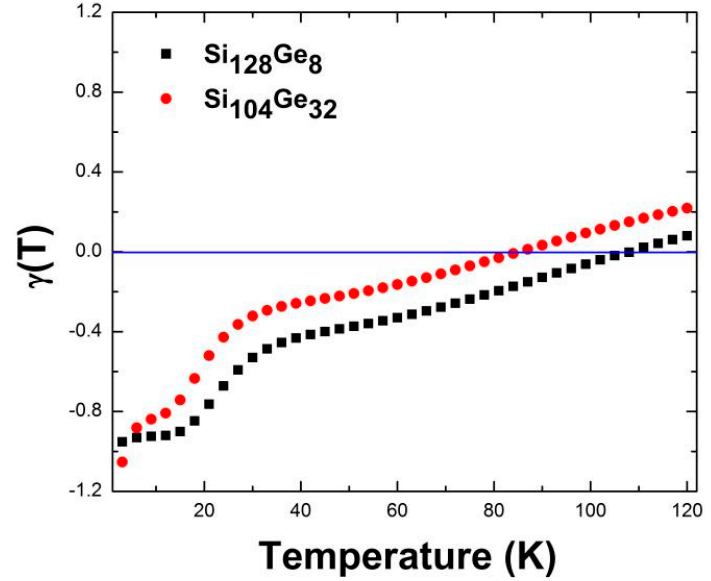
Figure 8. DFT-predicted macroscopic Grüneisen parameters of Si 128 Ge 8 and Si 104 Ge 32 .